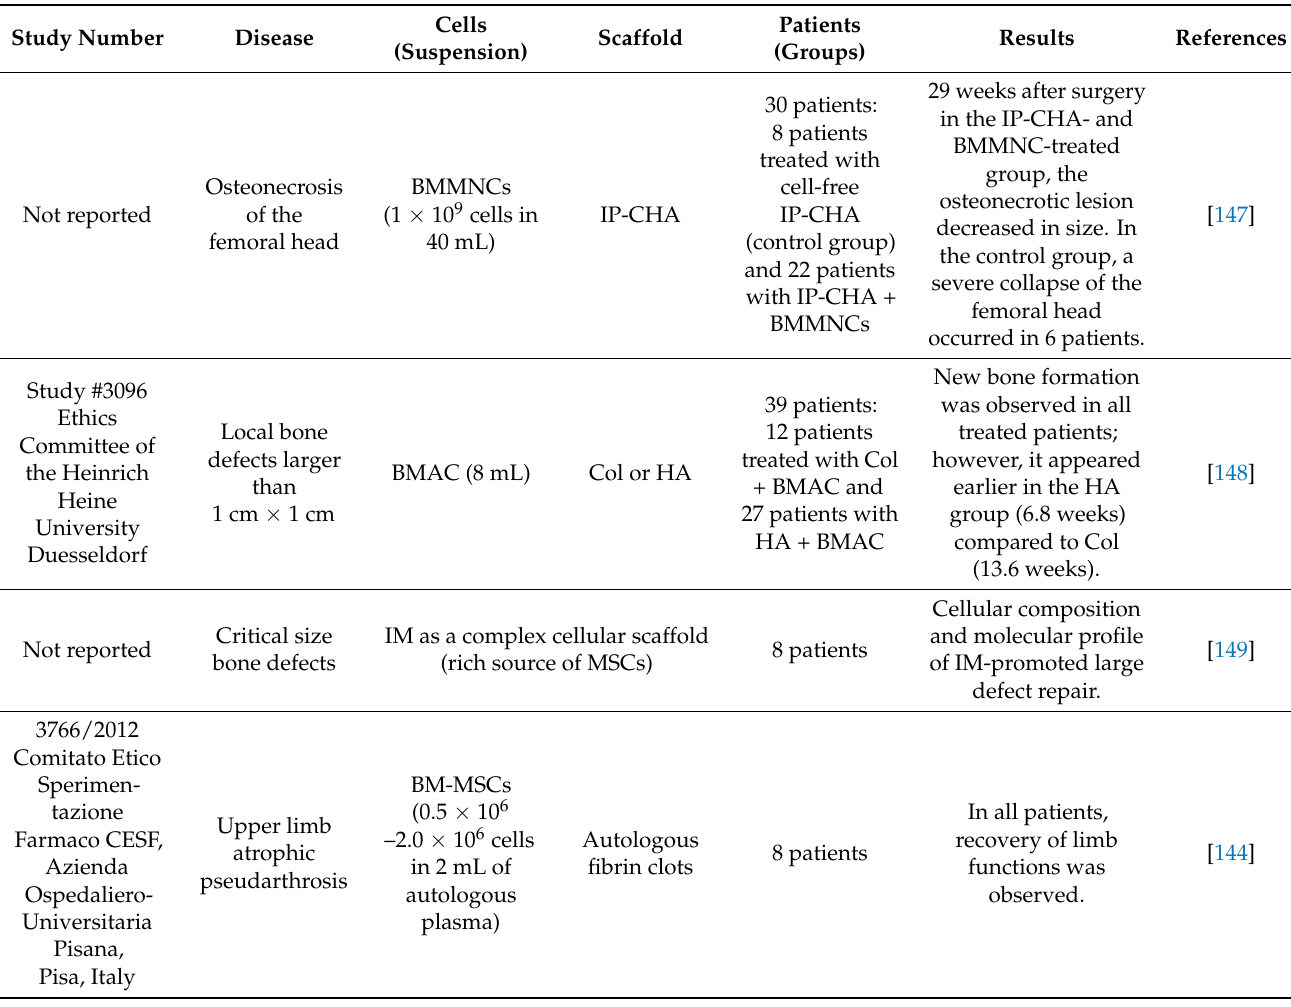
Table 2. MSC-based therapies with scaffolds for the repair of bone defects in clinical trials. Study